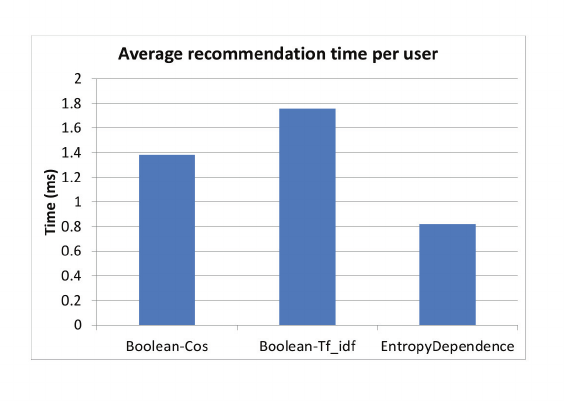
Fig. 5. Time spent in computing all user models